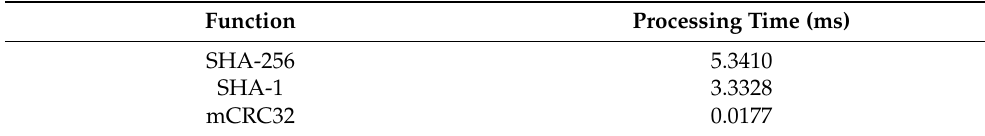
Table 5. Mean time taken to perform hash functions one time in Freescale